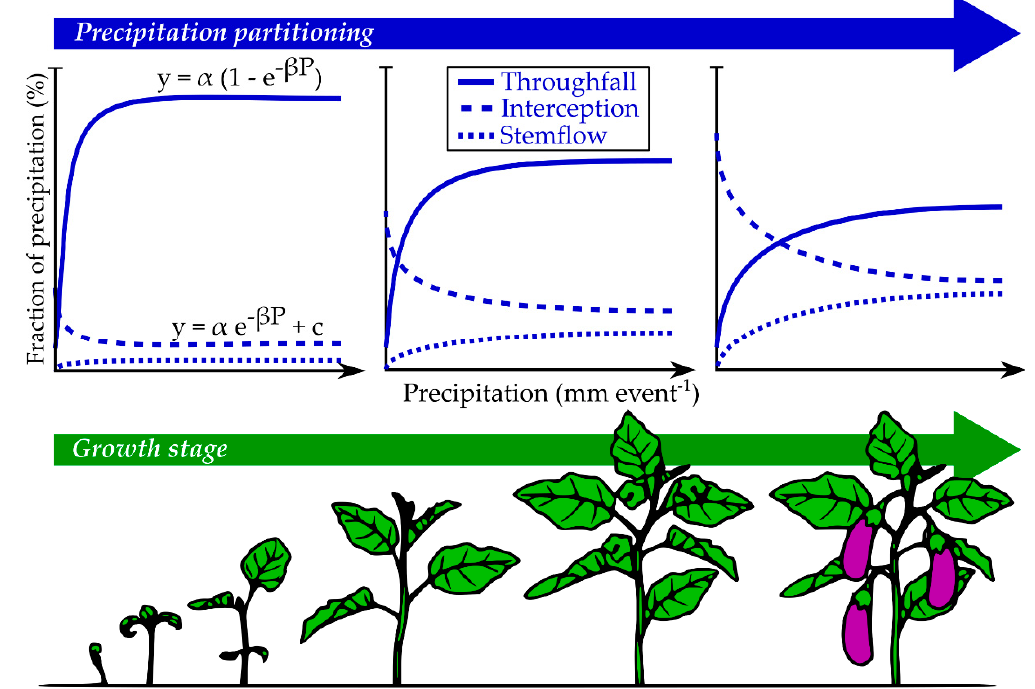
Figure 3. Conceptual model showing the interevent variability of precipitation partitions (throughfall, stemflow, and interception) across crop growth stages—e.g., [15,48] and references discussed in the text. Exponential formulae often fit to these trends [50,51] are provided in the upper left